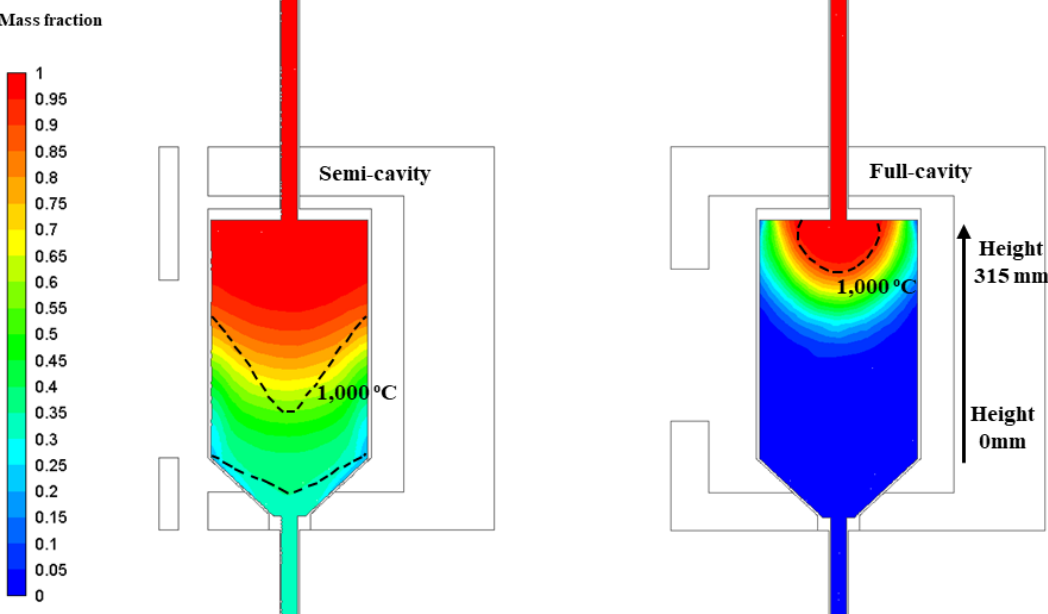
Figure 19. Methane mass fraction contour of center vertical cross-section of two reactors.